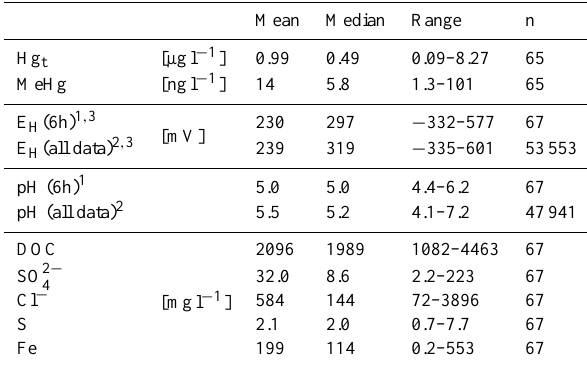
Table 2. Variations (mean, median, range) of concentrations of el- ements and compounds in the soluble fraction as well as pH, and redox potential (E H ) in the